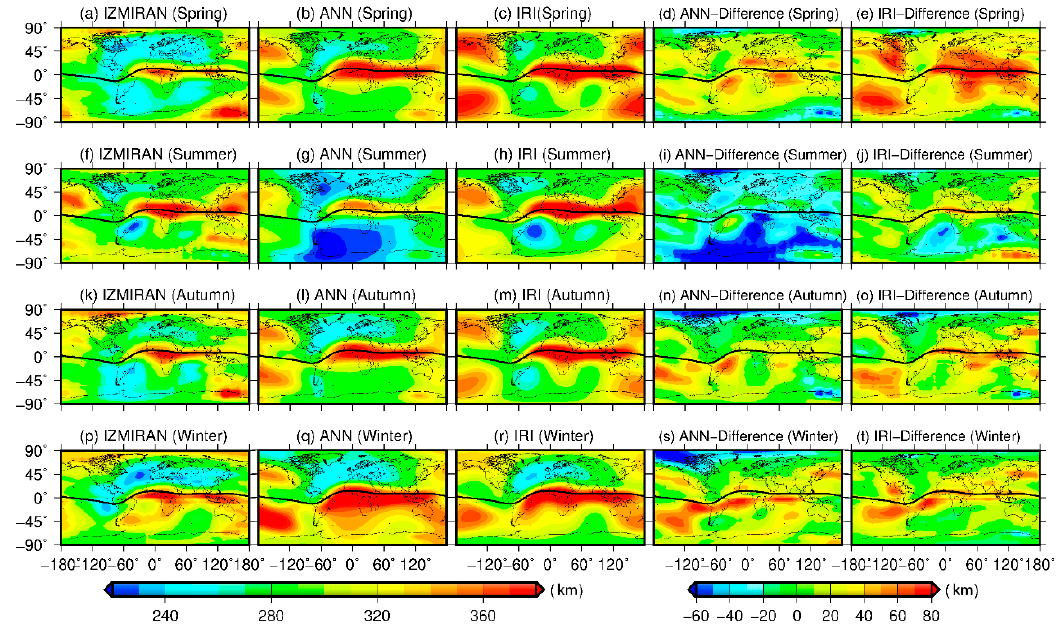
Figure 10. Similar to Figure 9, but for hmF2.